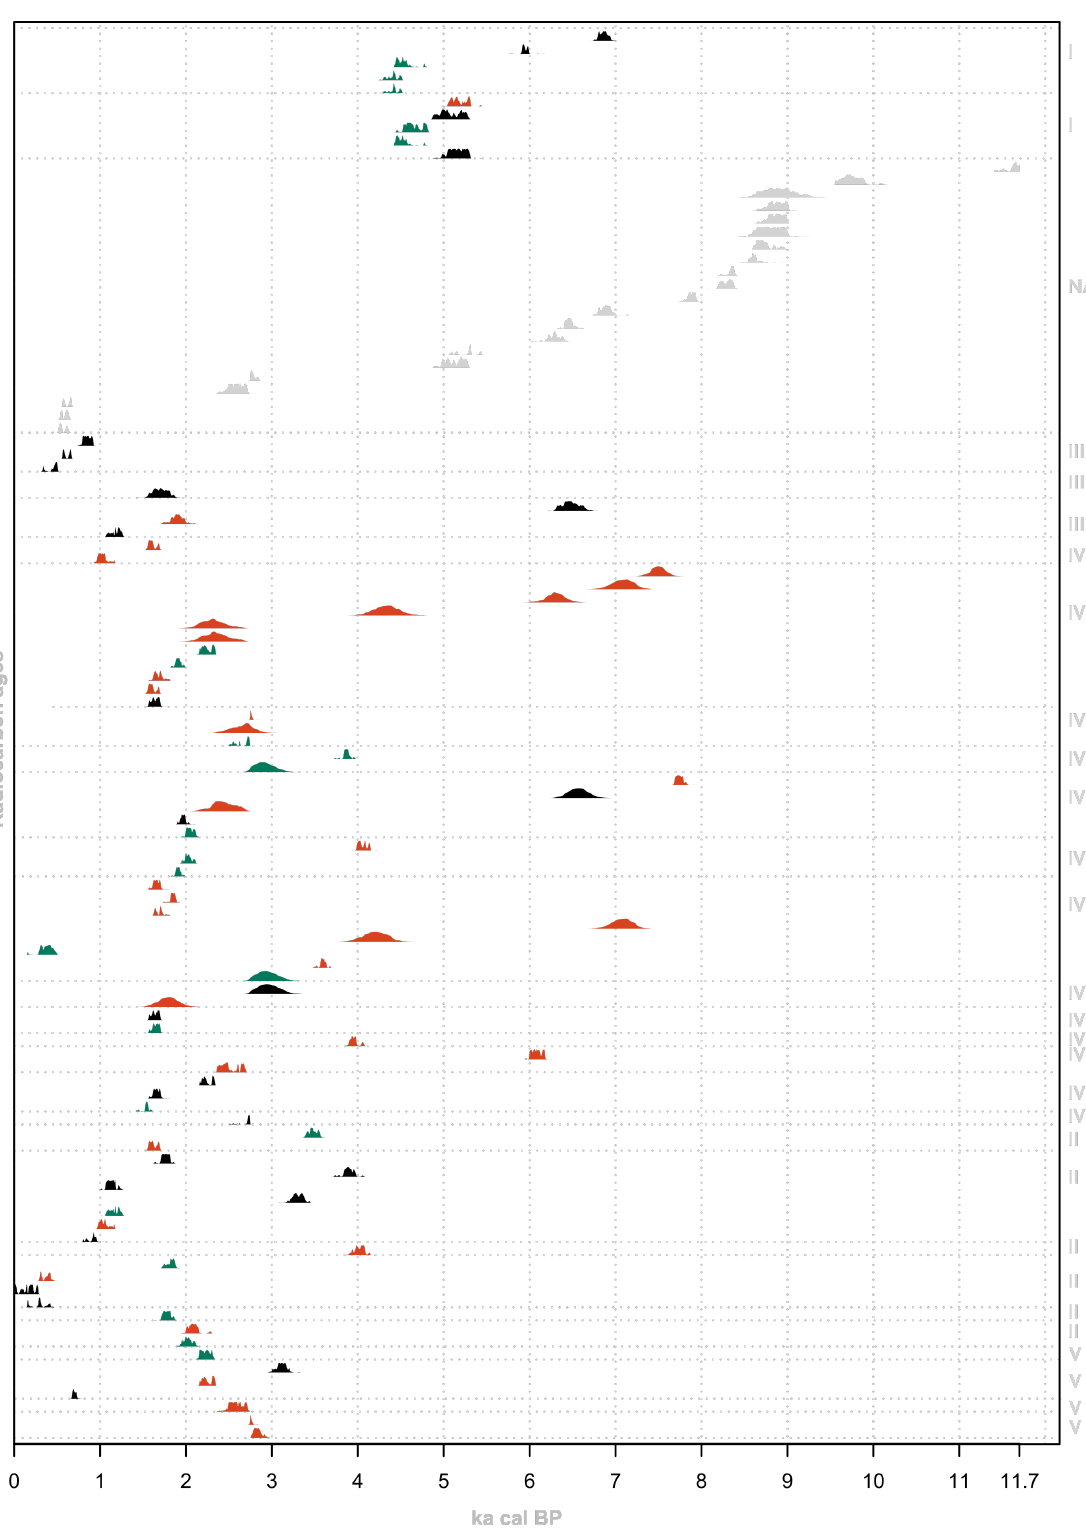
Figure 2. Overview on all 14 C-ages from the western lower Bakırçay plain included in our data base. Colors indicate different change-ages (black = no change, green = change-before, red = change-after) and ages where no stratigraphic information are available (grey). Horizontal dashed lines separate different sediment sequences. Probabilities of the dates are not normalized to sum to unity. Secondary y-axis: Location codes as given in Table 1 and Figure 1. Ages obtained from